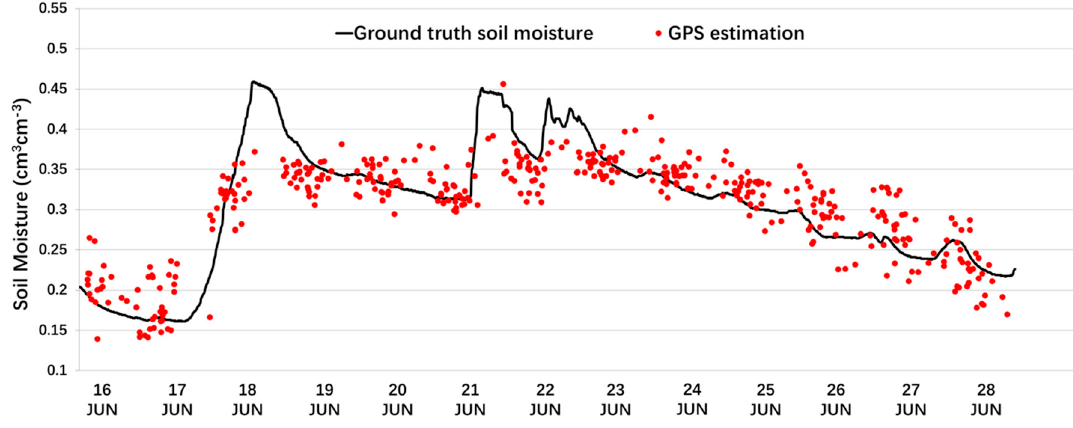
Figure 12. Estimation results of Wuhan experiment.